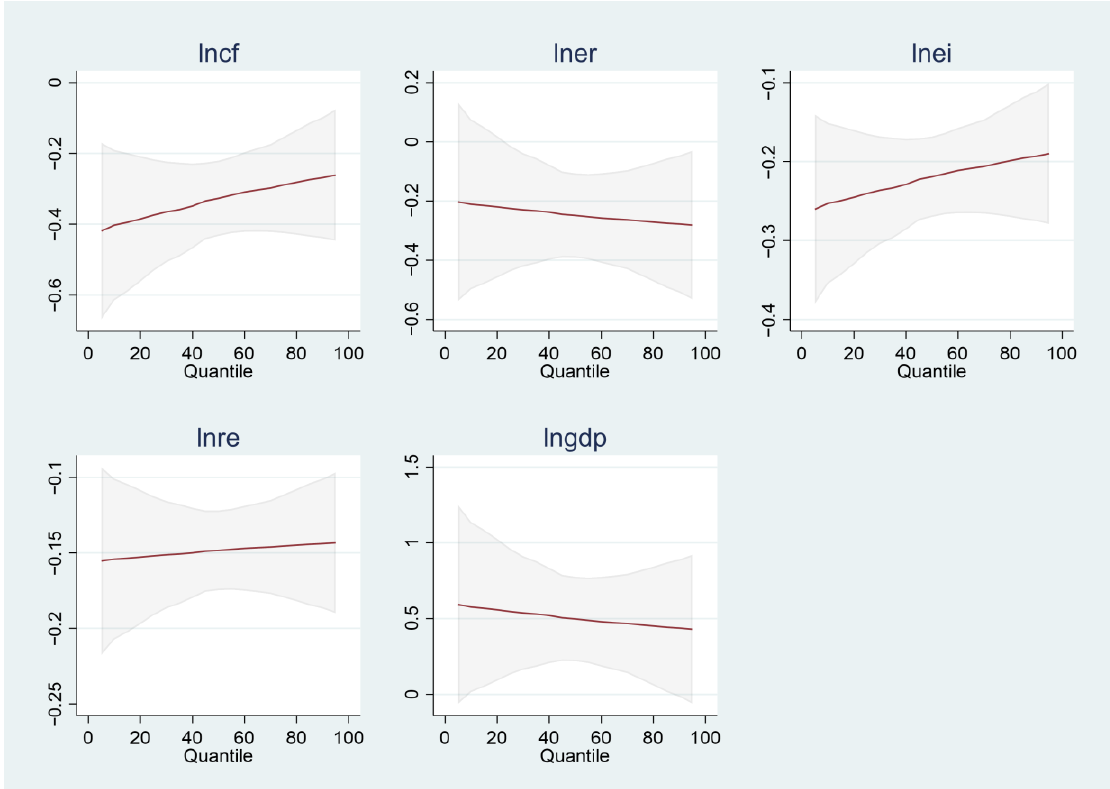
Figure 1. Quantile